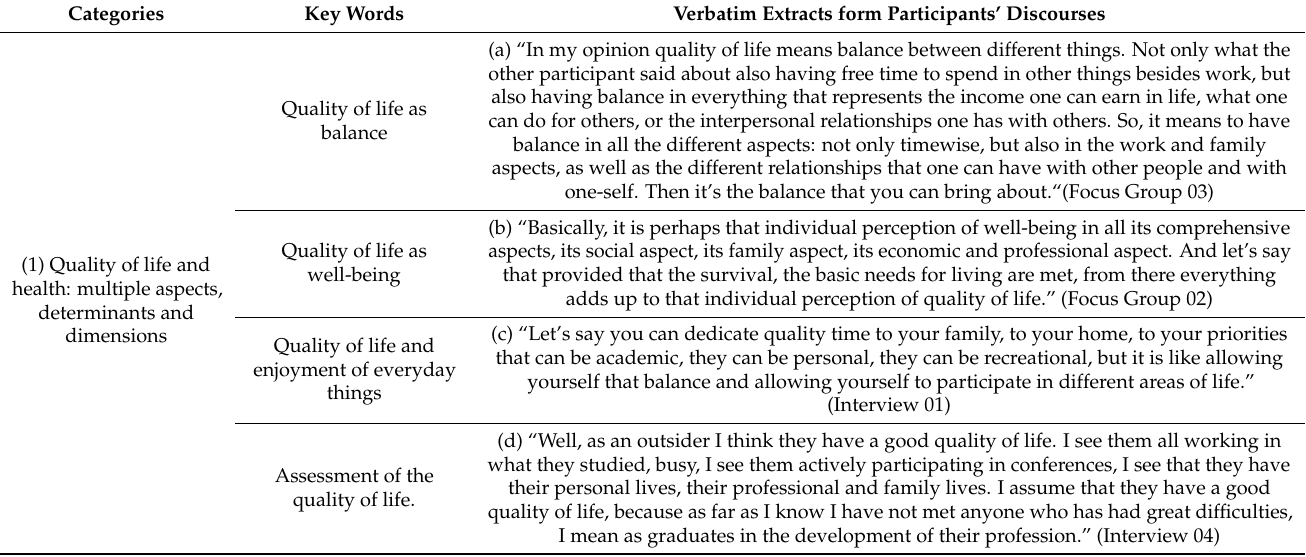
Table 5. Verbatim extracts from participants’ discourses: Focus groups ( n = 3) and semi-structured interviews ( n =